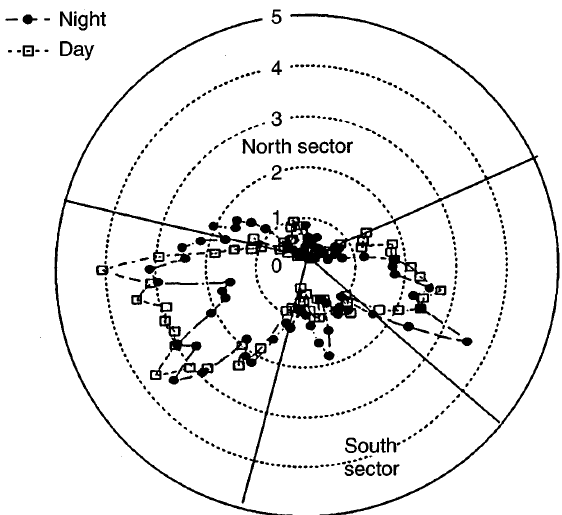
Fig. 5. The relative frequency (expressed in percent) of flow from 5 (cid:176) sectors at LM for the night hours (defined as 7:01 p.m.–7:00 a.m.) and the daytime hours (defined as 7:01